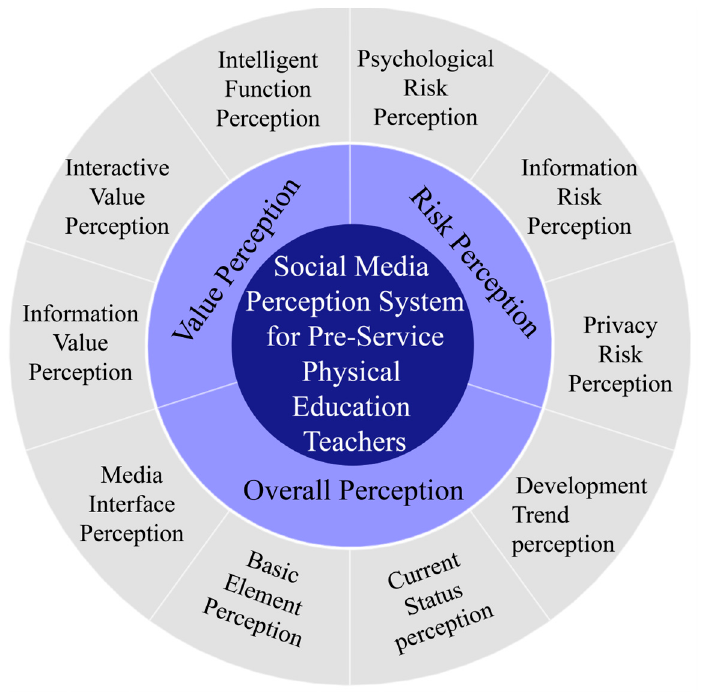
Figure 1. Pre ‐ service physical education teachers’ perception of social